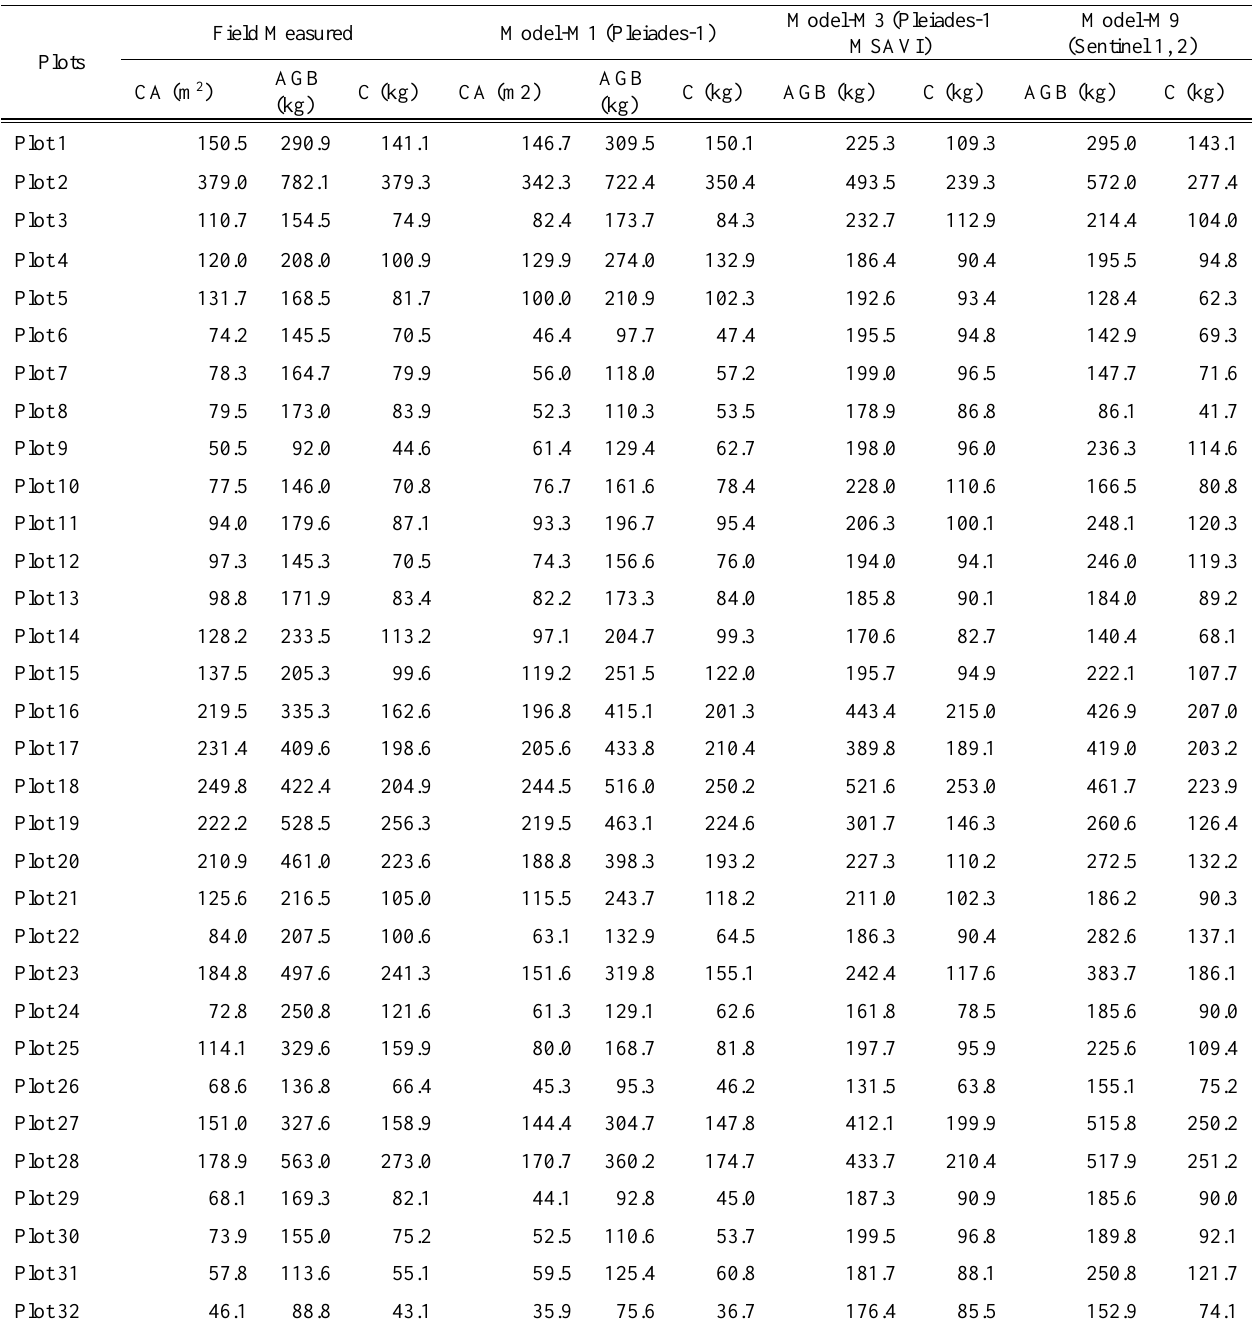
Table 5. The evaluation of biomass and carbon stock prediction from top-three models for each plot. The field Biomass (AGB) and Carbon stock (C) of above-ground biomass were estimated using an allometric equation for Haloxylon species from Buras et al., (2012). Carbon contents for above-ground biomass are 48.5%. AGB and C in kg/plot (plot area is 900 m 2